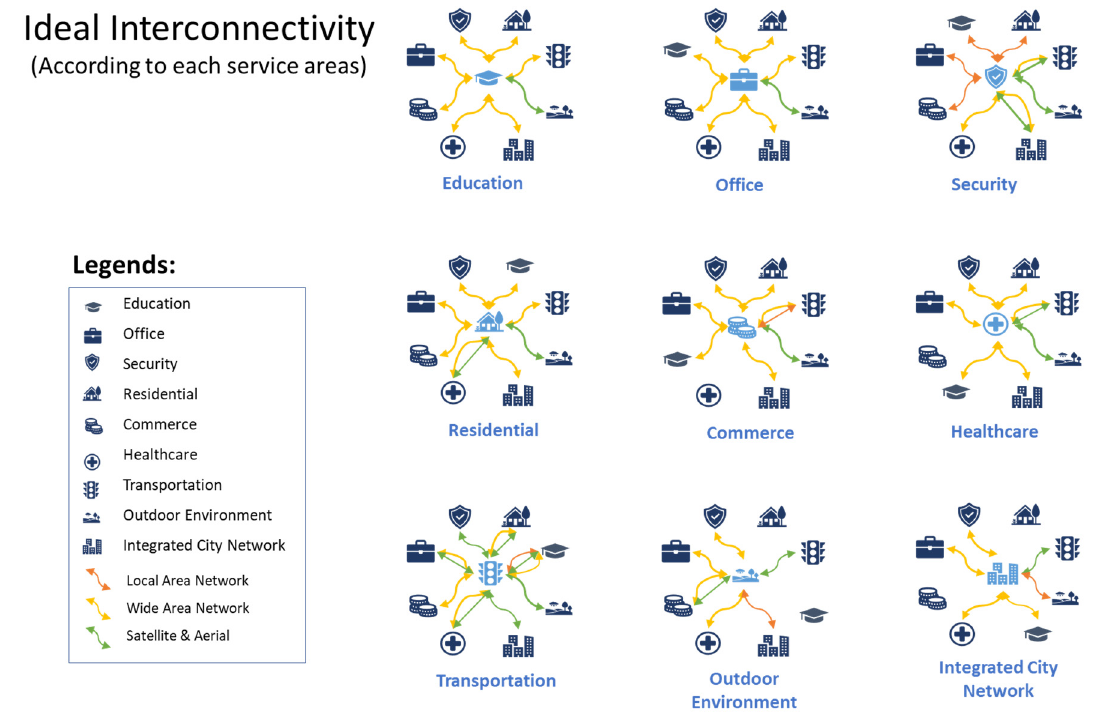
Figure 5. An ideal interconnectivity of service areas Performance of a U-city under hazards.